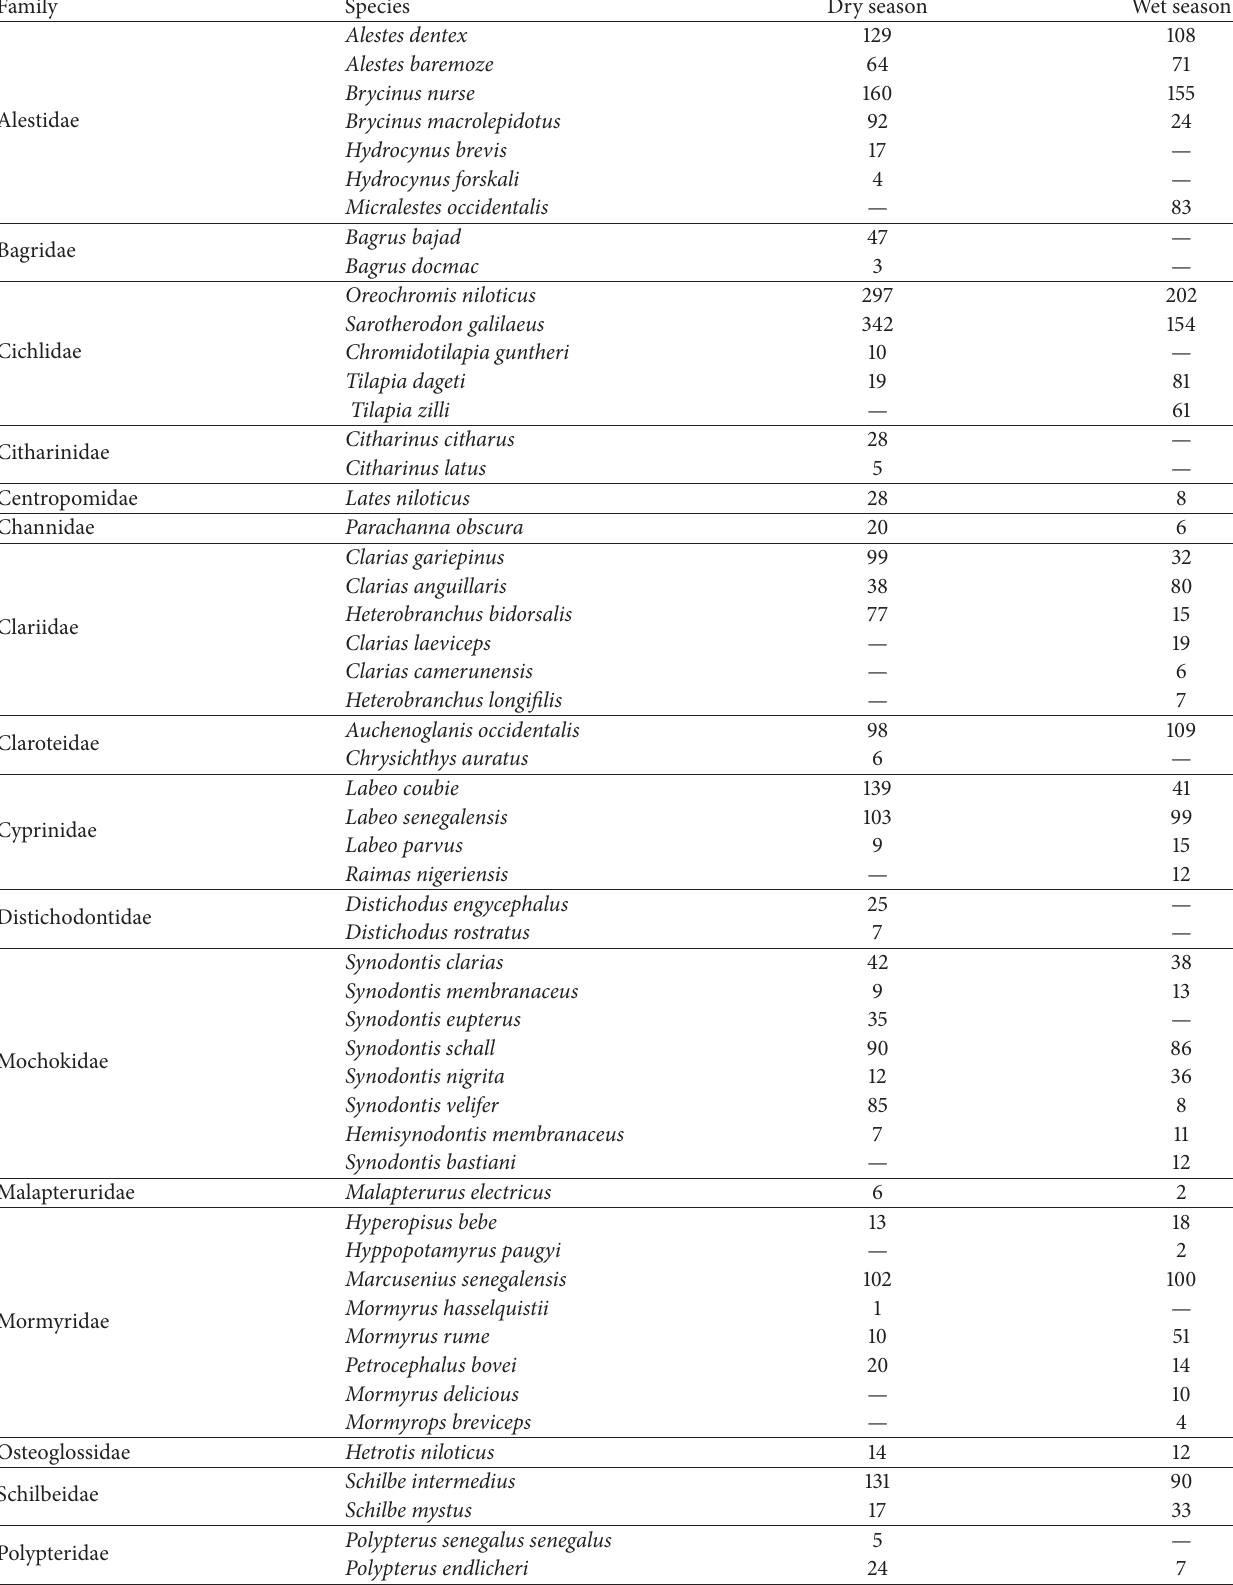
Table 2: Relative abundance of fish species recorded in the six sites, during the dry and wet seasons. (—) = absent.